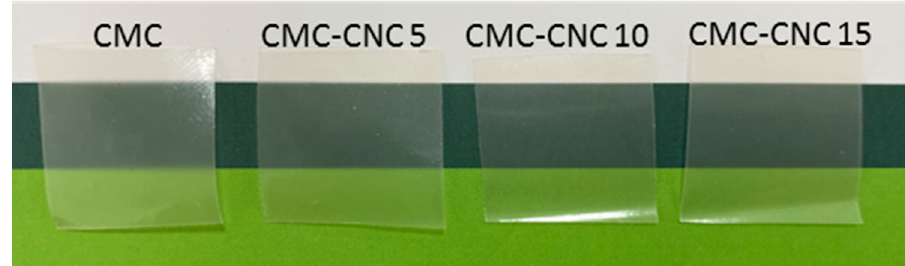
Figure 1. Visual aspect of CMC-G and CMC-CNC films.